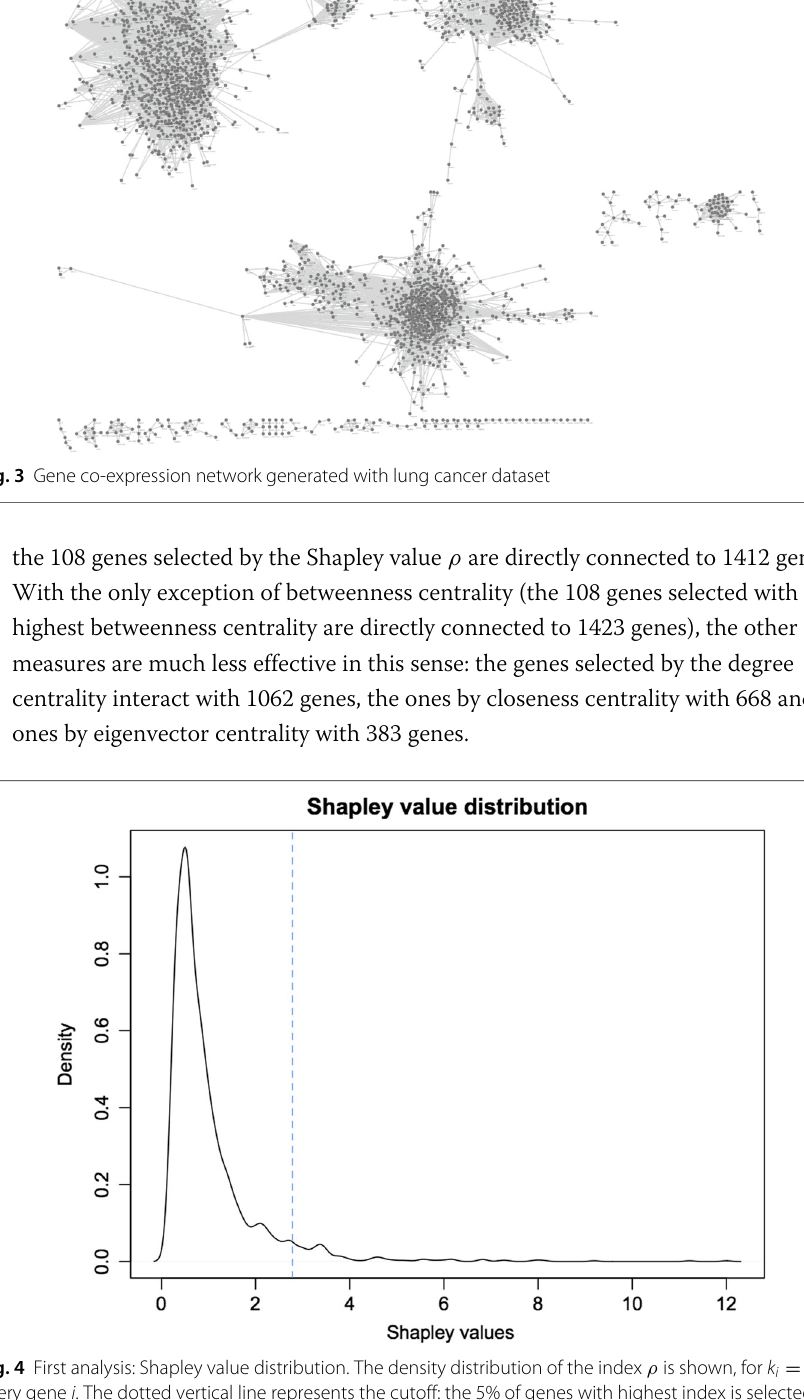
Fig. 4 First analysis: Shapley value distribution. The density distribution of the index ρ is shown, for k i = 1 for every gene i . The dotted vertical line represents the cutoff: the 5% of genes with highest index is